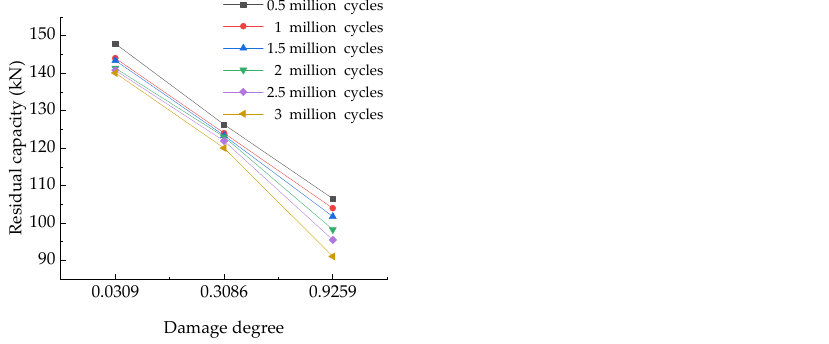
Figure 25. The relationship between the residual ultimate load capacity and damage degree.